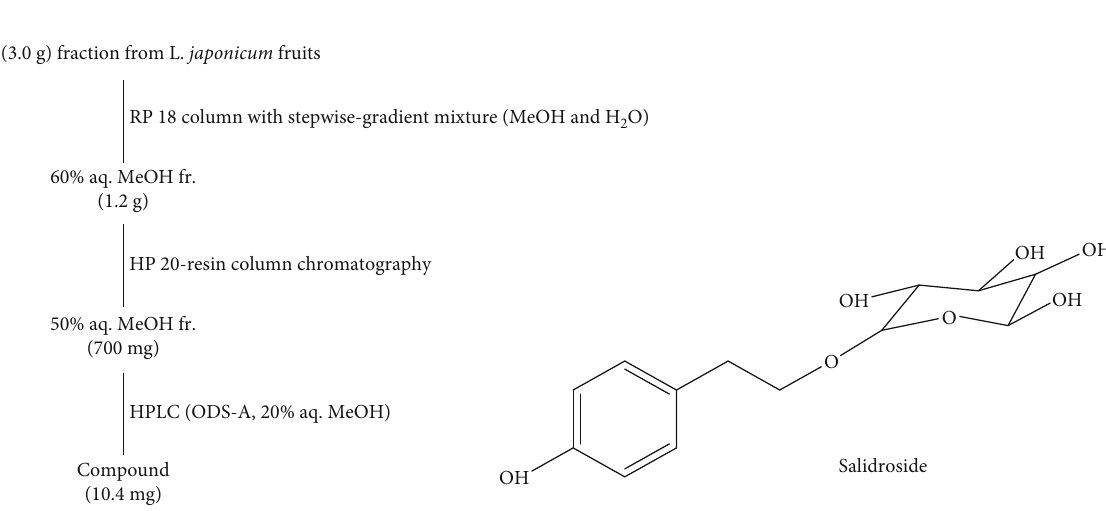
Figure 4: E ff ects of solvent fractions (H O, 85% aq. MeOH, n -BuOH, and n -hexane) on adipogenic and osteogenic di ff erentiation of hBM- 2 MSCs. (a) hBM-MSCs were seeded in 6-well plates and osteo-induced with or without fractions (10 and 50 μ g/ml). Cellular ALP activity of osteo-induced hBM-MSCs was measured with a spectrophotometric enzymatic activity assay at day 7 of di ff erentiation. (b) Adipo-induced hBM-MSCs in 6-well plates with or without fractions (10 and 50 μ g/ml) were stained with Oil Red O at day 14 of di ff erentiation. Images of cells show stained lipid droplets (left panel). Lipid accumulation levels were calculated by the colorimetric quanti fi cation of the dye removed from the wells (right panel) and given as percentage of the untreated di ff erentiated control group. (c) Adipogenic and (d) osteogenic protein levels were analyzed with Western blotting. Western blot bands were densitometrically quanti fi ed and plotted as relative percentage of the untreated di ff erentiated control group. β -Actin was used as internal loading control. ∗ p < 0 : 05 and ∗∗ p < 0 : 01 vs. the untreated di ff erentiated control group. Scale bar: 50 μ m.